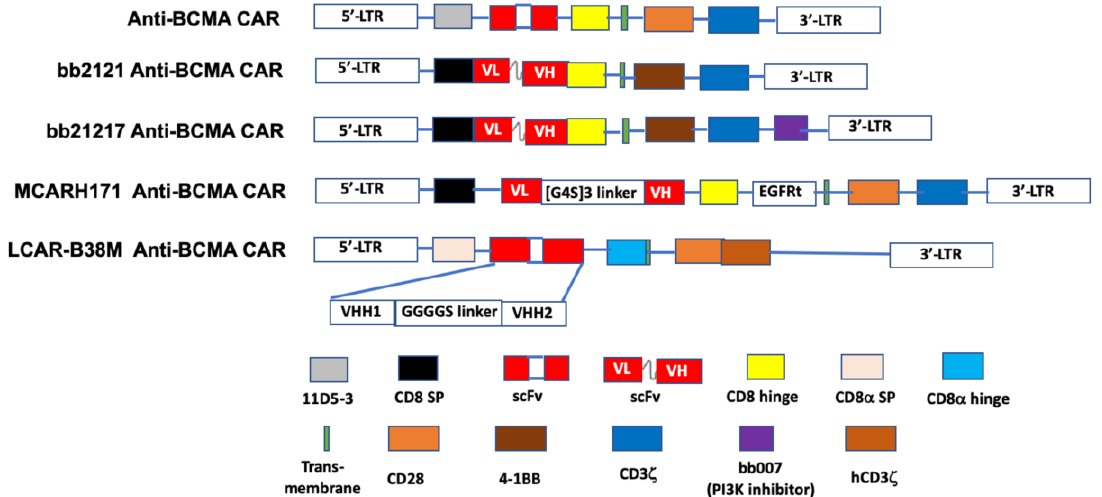
Figure 2. The schematic diagram of representative structures of BCMA-targeted chimeric antigen receptors (CAR). The BCMA CARs contain a single- chain of BCMA antibody variable fragment (ScFv), a transmembrane domain, a hinge region, a co-stimulation domain (4-1BB, CD28 or OX40), and a CD3  domain. Additional sequences (such as PI3K inhibitor) are added to enhance identification of CAR+ T cells. LCAR-B38M CAR contains two epitopes of BCMA scFv, VHH1 and VHH2. PI3K: phosphoinositol 3-kinase. Adapted from Lin et al. [156] with permission through Copyright Clearance Center,